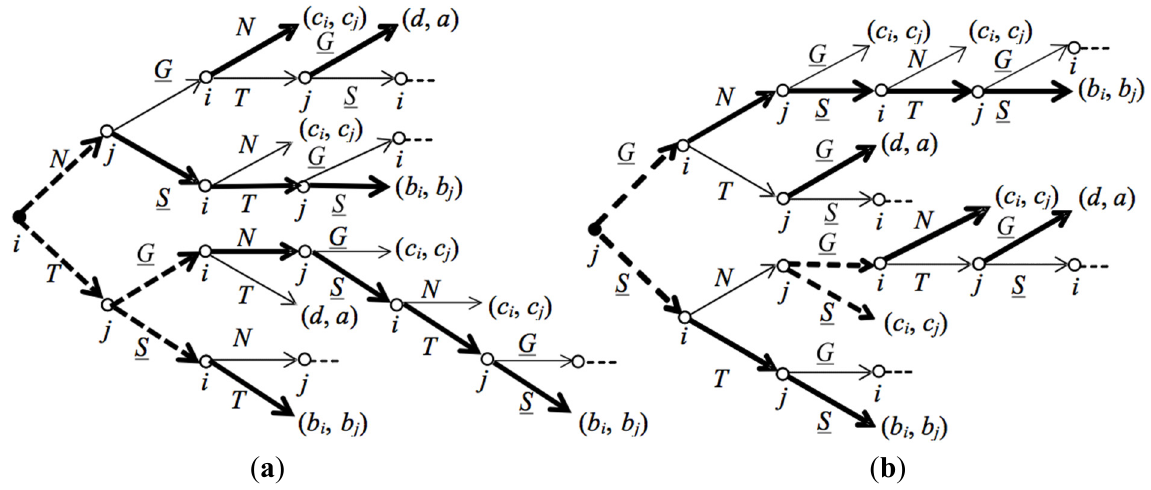
Figure 14. CP ( G ), G being the Trust Minigame, with i ( a ) or j ( b ) as first